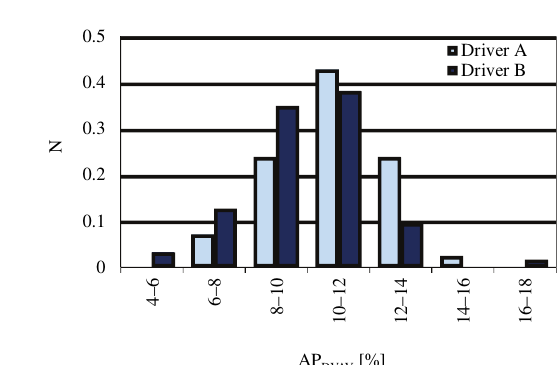
Fig. 30. Average value of the derivative of the relative position of accelerator pedal in urban driving conditions